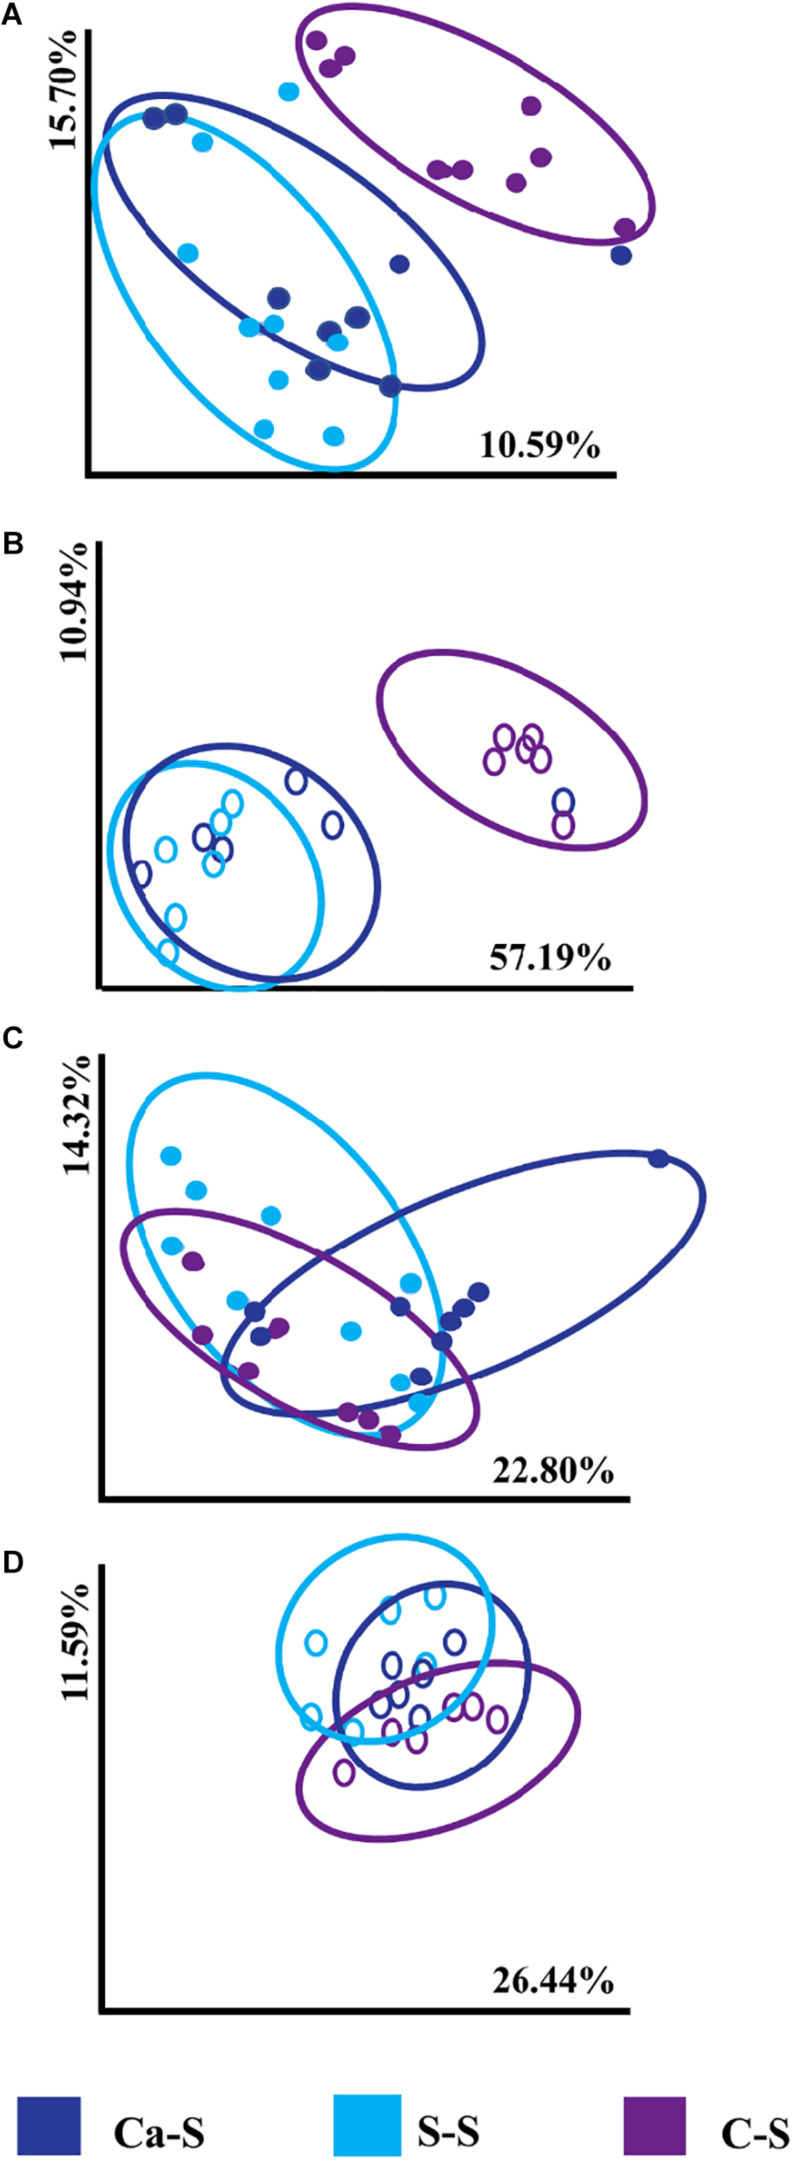
Principal coordinate analysis (PCoA), represented by Bray-Curtis dissimilarities between samples and calculated using the 16S rRNA amplicon sequences for bacterial samples and the ITS1 and ITS2 amplicon sequences of fungal samples. Soils were obtained from the Ca-S, S-S, and C-S crop sequences in the bulk and rhizosphere soil for all time-points. For each axis, the percent of variation is indicated. The dark blue filled and open circles represent the canola-soybean sequence (Ca-S), light blue filled and open circles are the soybean-soybean sequence (S-S) and the purple filled and open circles are the corn-soybean sequence (C-S). Each dot represents the average of three biological replicates and each biological replicate represents five pooled core soil samples. Comparison of cumulative Bray-Curtis dissimilarities for panel (A) bacterial in the bulk soil (B) bacterial in the rhizosphere soil (C) fungal in the bulk soil (D) fungal in the rhizosphere soil.